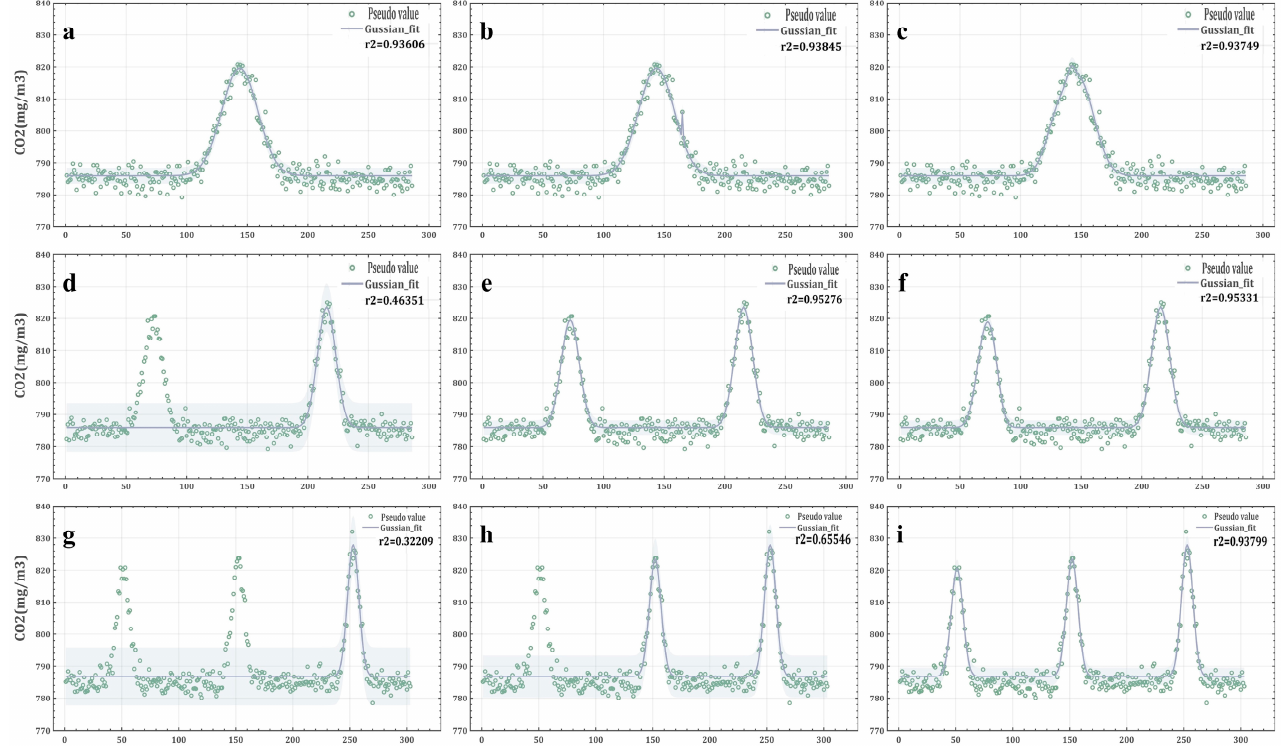
Figure 2. Multivariate Gaussian fitting results.